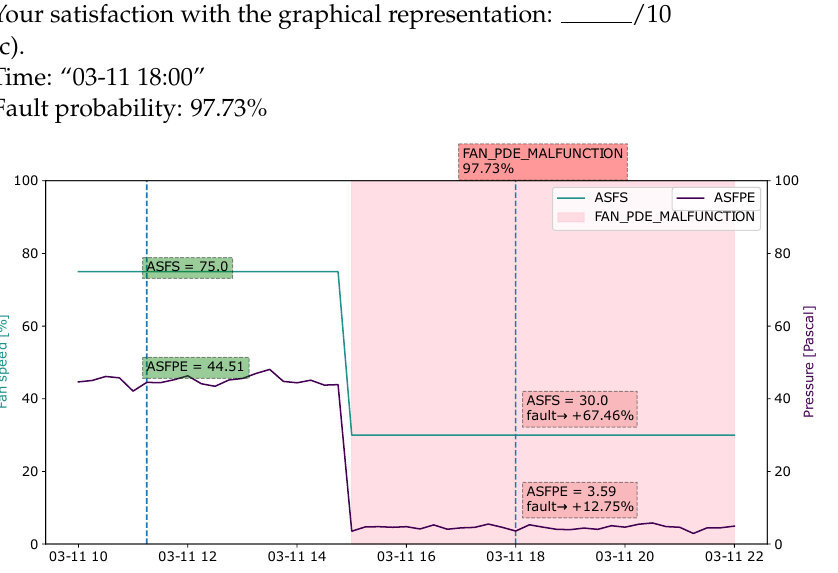
Figure A3. Fan pressure sensor malfunction. SHAP plot for sliding window explanation visualized from “03-11 10:00” to “03-11 22:00”; x axis represents 15 min time instances. Does the above plot explain fan pressure sensor malfunction? (Strongly Agree / Somewhat Agree / Neutral / Somewhat Disagree / Strongly Disagree)